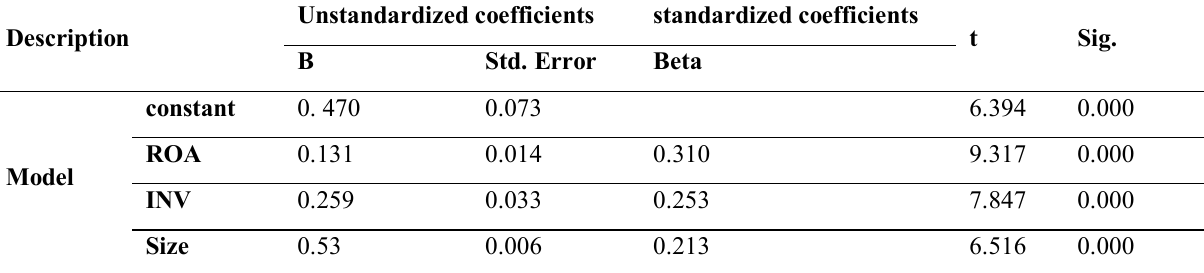
Table 6 –independent variables` coefficient Significance